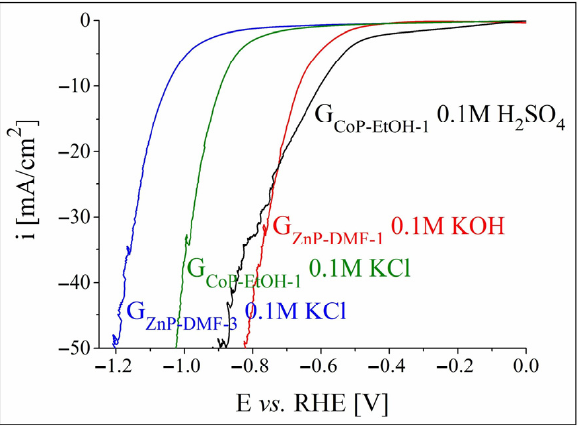
Figure 4. Cathodic polarisation curves recorded in 0.1 M electrolyte solutions for the most electrocatalytically active ZnP- and CoP-modified electrodes at v = 5 mV/s.